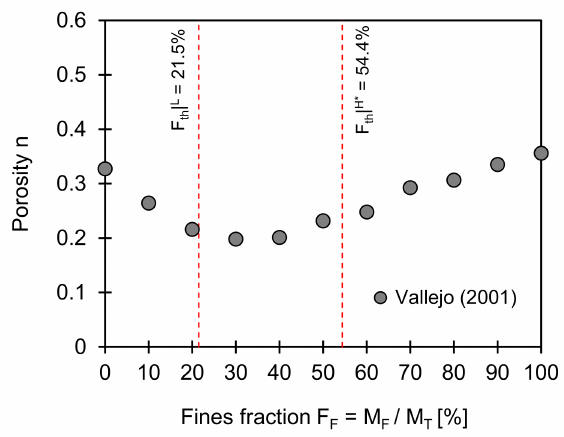
Figure 1. Porosity versus fines fraction. Two red dotted lines indicate low and data-adjusted high- threshold fines fractions computed using Equations (2) and (4). Input parameters used for estimation of two boundaries are e Cmax = 0.805, e Cmin = 0.533, e Fmax = 0.949; e Fmin = 0.689, and F th | L = 21.5%, and F th | H * = 54.4%. Note: Data extracted from Vallejo [30].